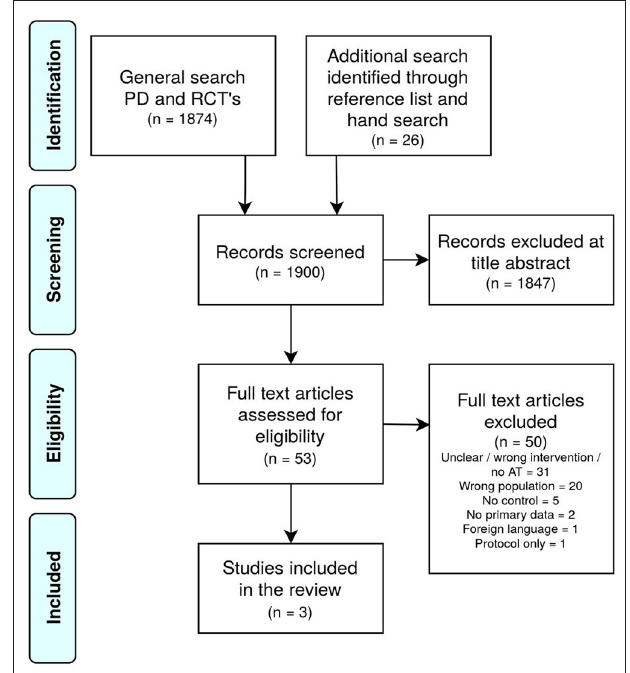
FIGURE 1 | Prisma diagram of the search results.